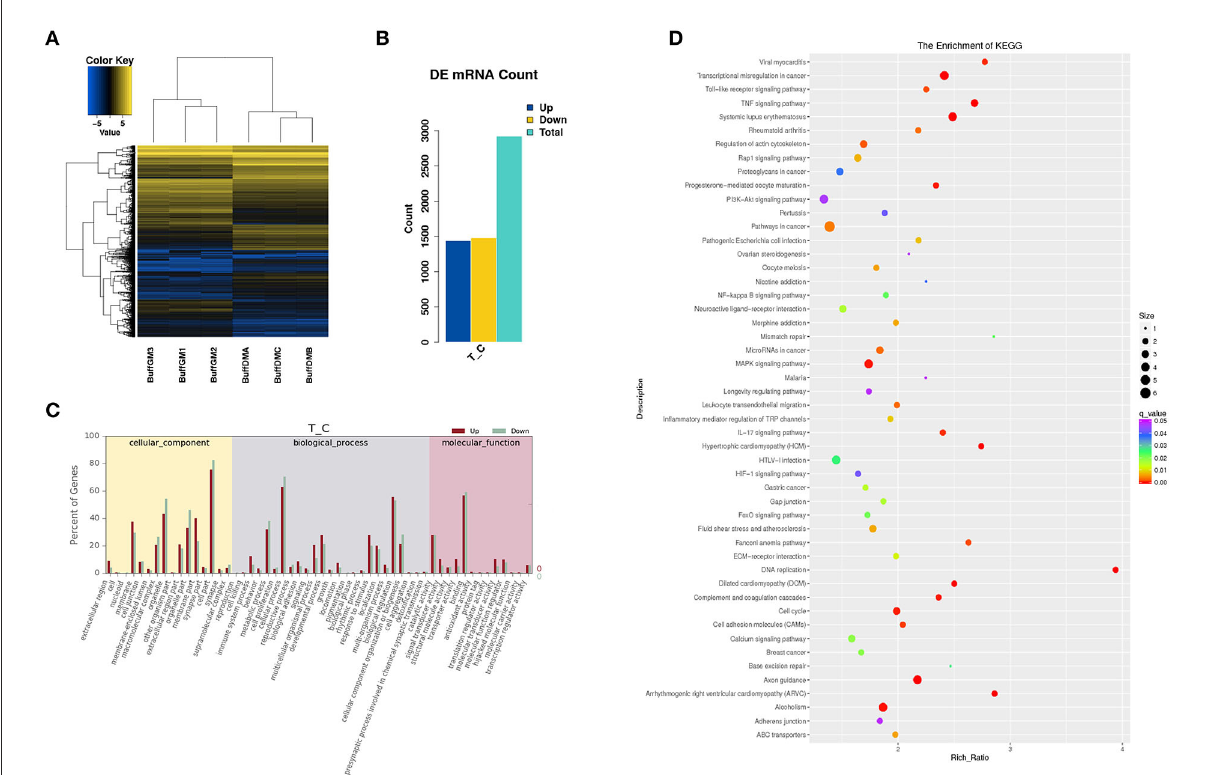
FIGURE4 Differentially expressed mRNAs in proliferating and differentiating buffalo myoblasts. (A,B) A heatmap and histogram of the differentially expressed lncRNAs in proliferating and differentiating buffalo myoblasts. (C,D) The enriched GO terms and KEGG pathways are shown. BuffGM represents buffalo muscle cells at the proliferative phase and BuffDM represents buffalo muscle cells at the differentiation